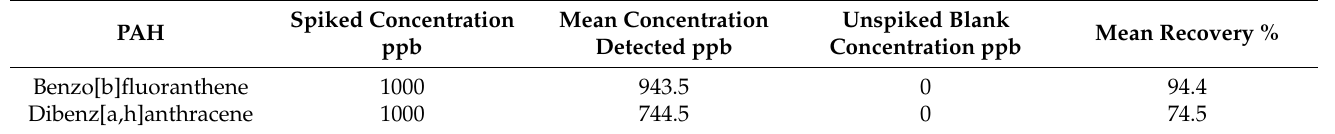
Table 3. Recovery of PAHs as determined comparing spiked blanks and unspiked